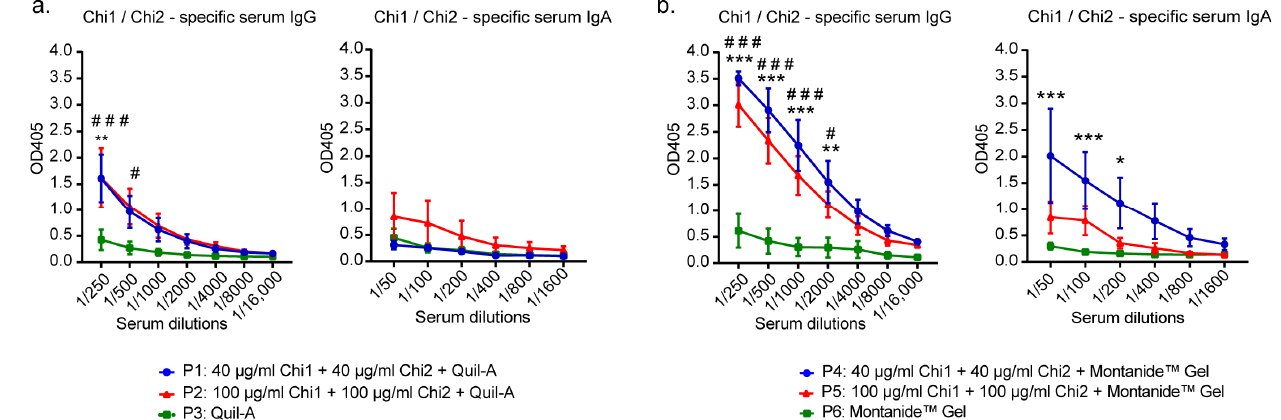
Figure 4. Chi1/Chi2—specific antibody levels present in the serum of newborn calves. ( a ) Newborn calves from groups P1, P2 and P3. ( b ) Newborn calves from groups P4, P5 and P6. Data analysis was by a two ‐ way ANOVA, followed by Tukey’s multiple comparison test. p < 0.05 was considered significant. Asterisks (*) indicate significant differences between the group immunized with the formulation containing 40 μ g of each chimeric antigen and the control group (adjuvant alone). * p < 0.05, ** p < 0.005, *** p < 0.0005. Number signs (#) indicate significant differences between the group